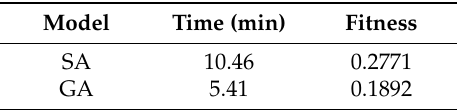
Table 3. The comparison of GA and SA over 150 iterations with the same initial